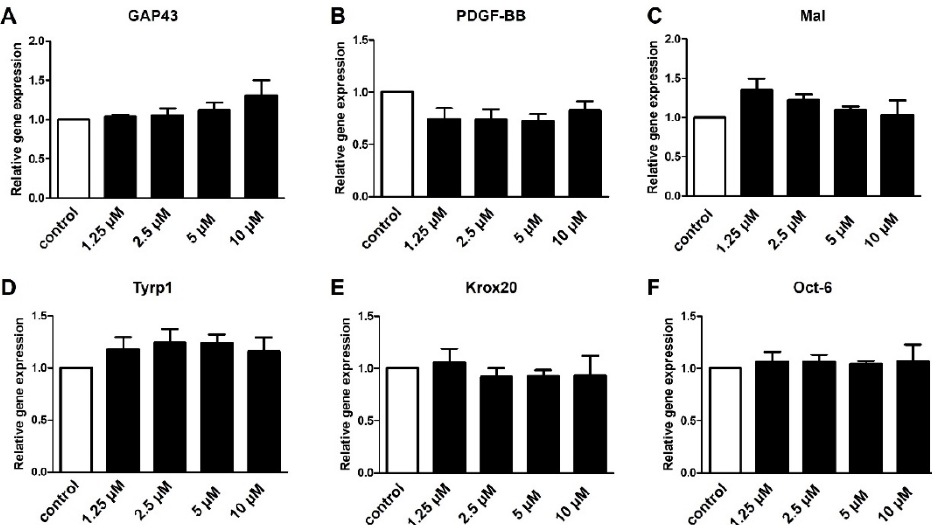
Figure 8. Schwann cell transdifferentiation does not depend on S1P5. Modulation of S1P5 with a specific agonist (A971432) applied in different concentrations did not affect the expression of GAP43 ( A ), PDGF-BB ( B ), Mal ( C ), Tyrp1 ( D ), Krox20 ( E ) or Oct-6 ( F ). For statistical analysis, a one-way ANOVA with Dunnett’s multiple comparison test was used, n = 4–5. Shown are the mean values ± SEM.